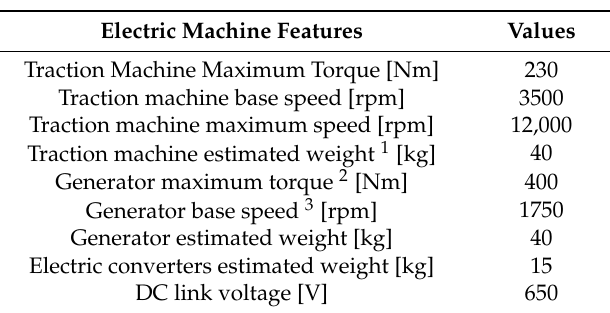
Table 3. Electric machine features.